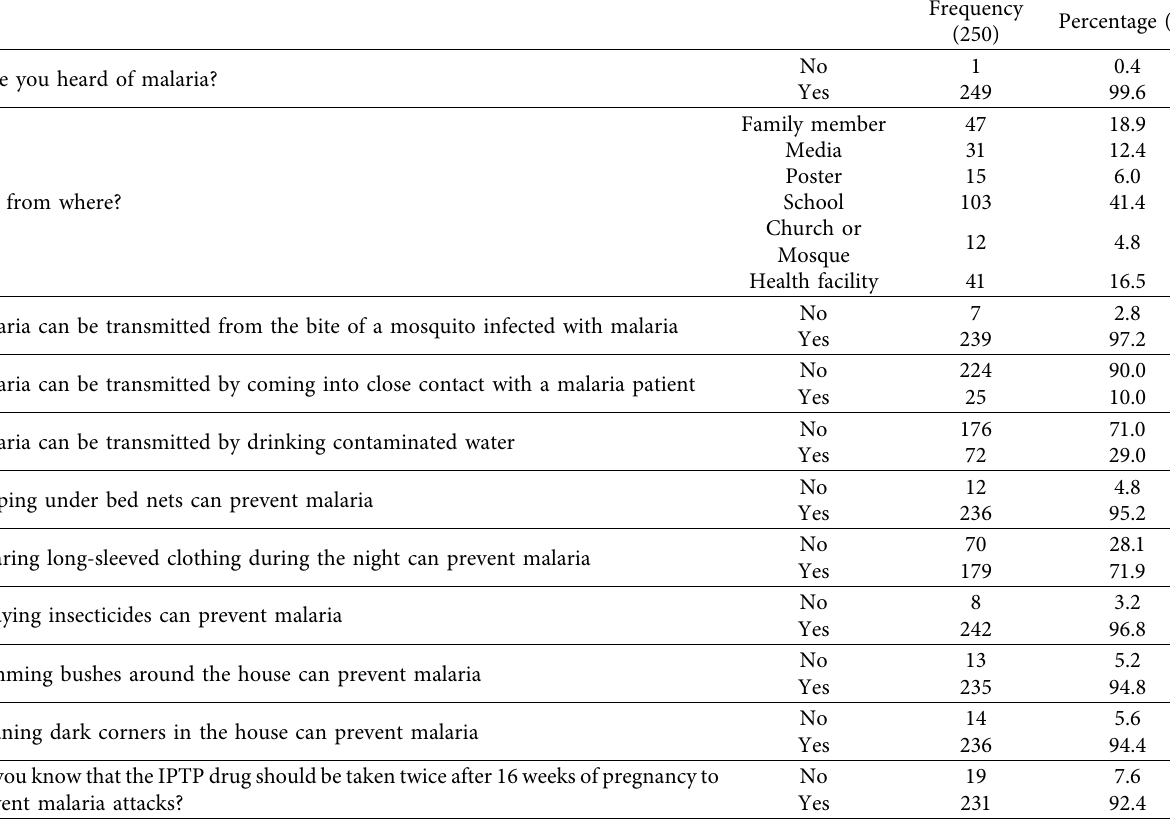
Table 2: Respondents’ knowledge on malaria preventive measures.